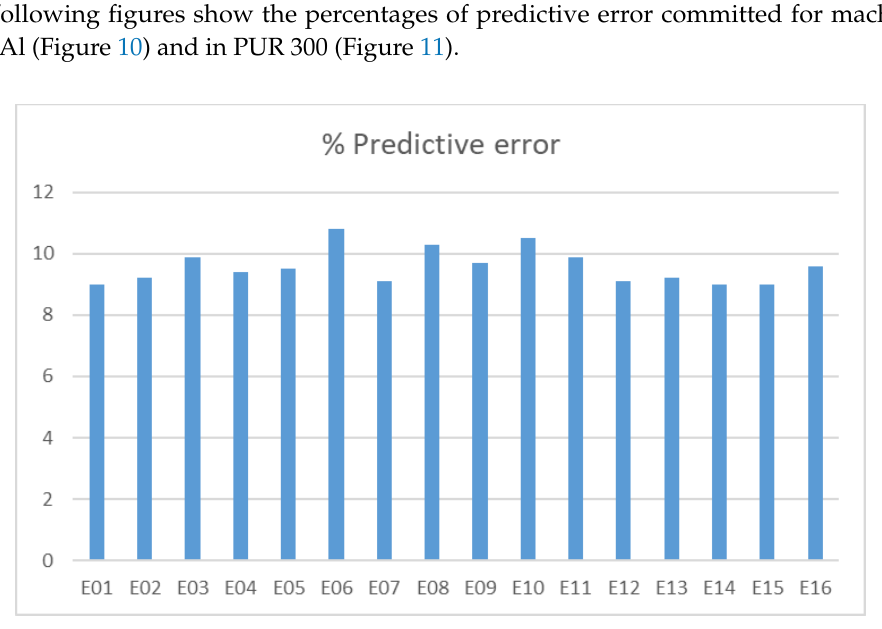
Table 6. Machining variables and parameters for